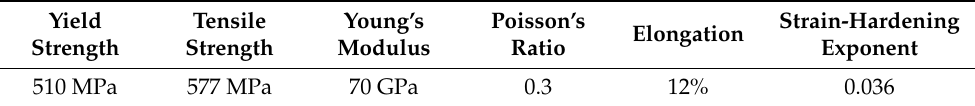
Table 2. Mechanical properties of the test